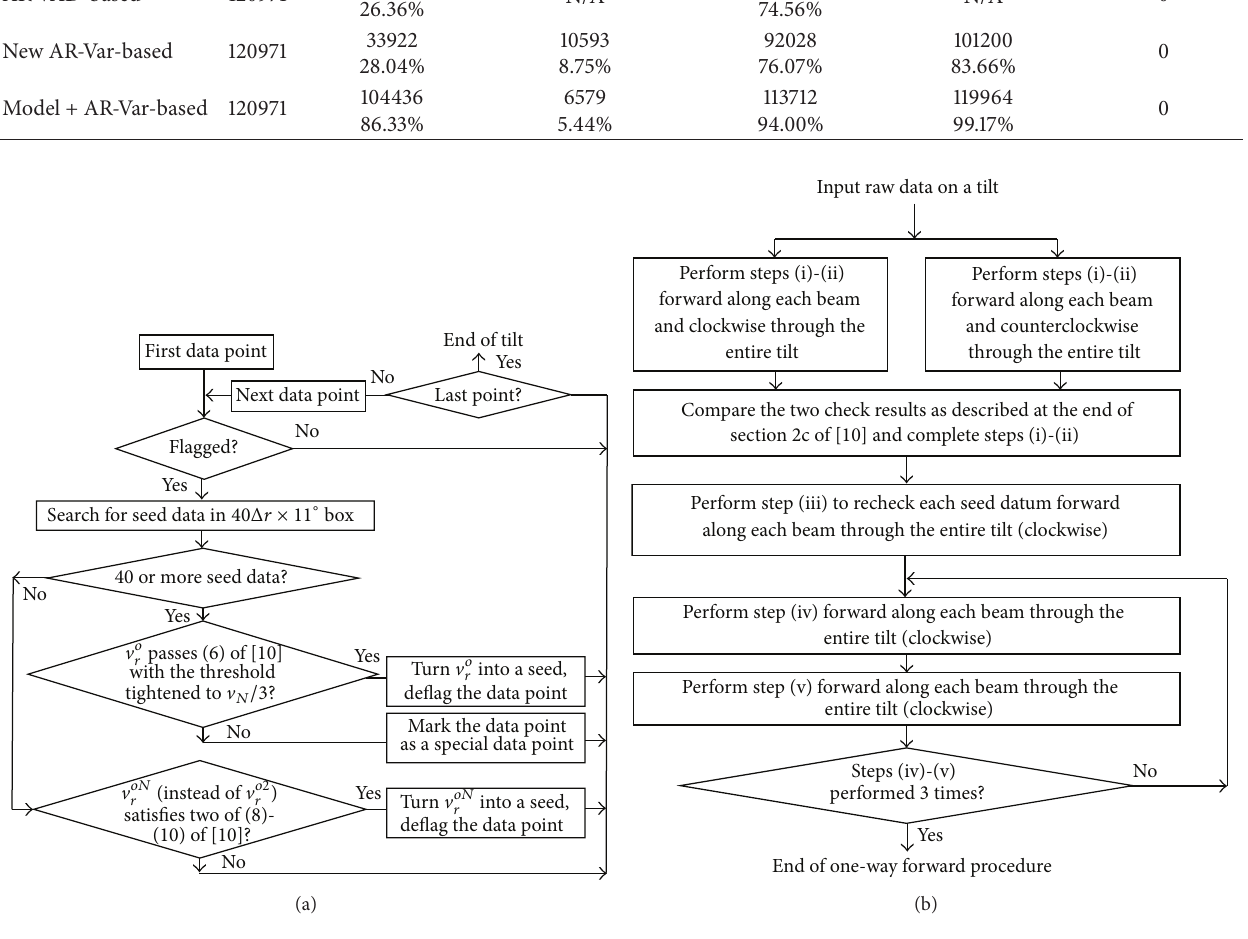
Figure 3: (a) Flowchart for the modified block-to-point continuity check and modified three-directional continuity check in steps (i)-(ii). (b) Flowchart for the first one-way forward procedure from step (i) to step (v) in the continuity